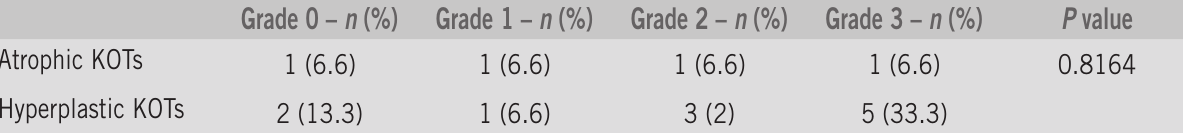
Mean number of CD1a-positive LCs in KOTs according to the degree of inflammation